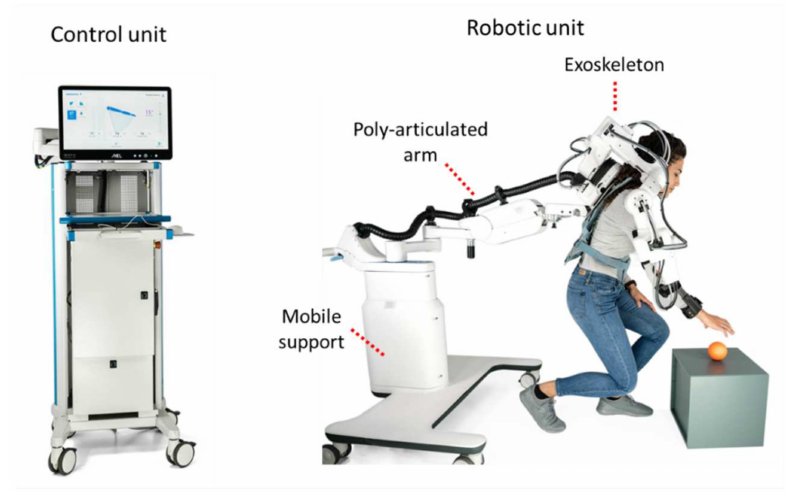
Figure 2. Float system overview. Left : The control unit; Right : The robotic unit (Exoskeleton, polyarticulated arm and mobile support).